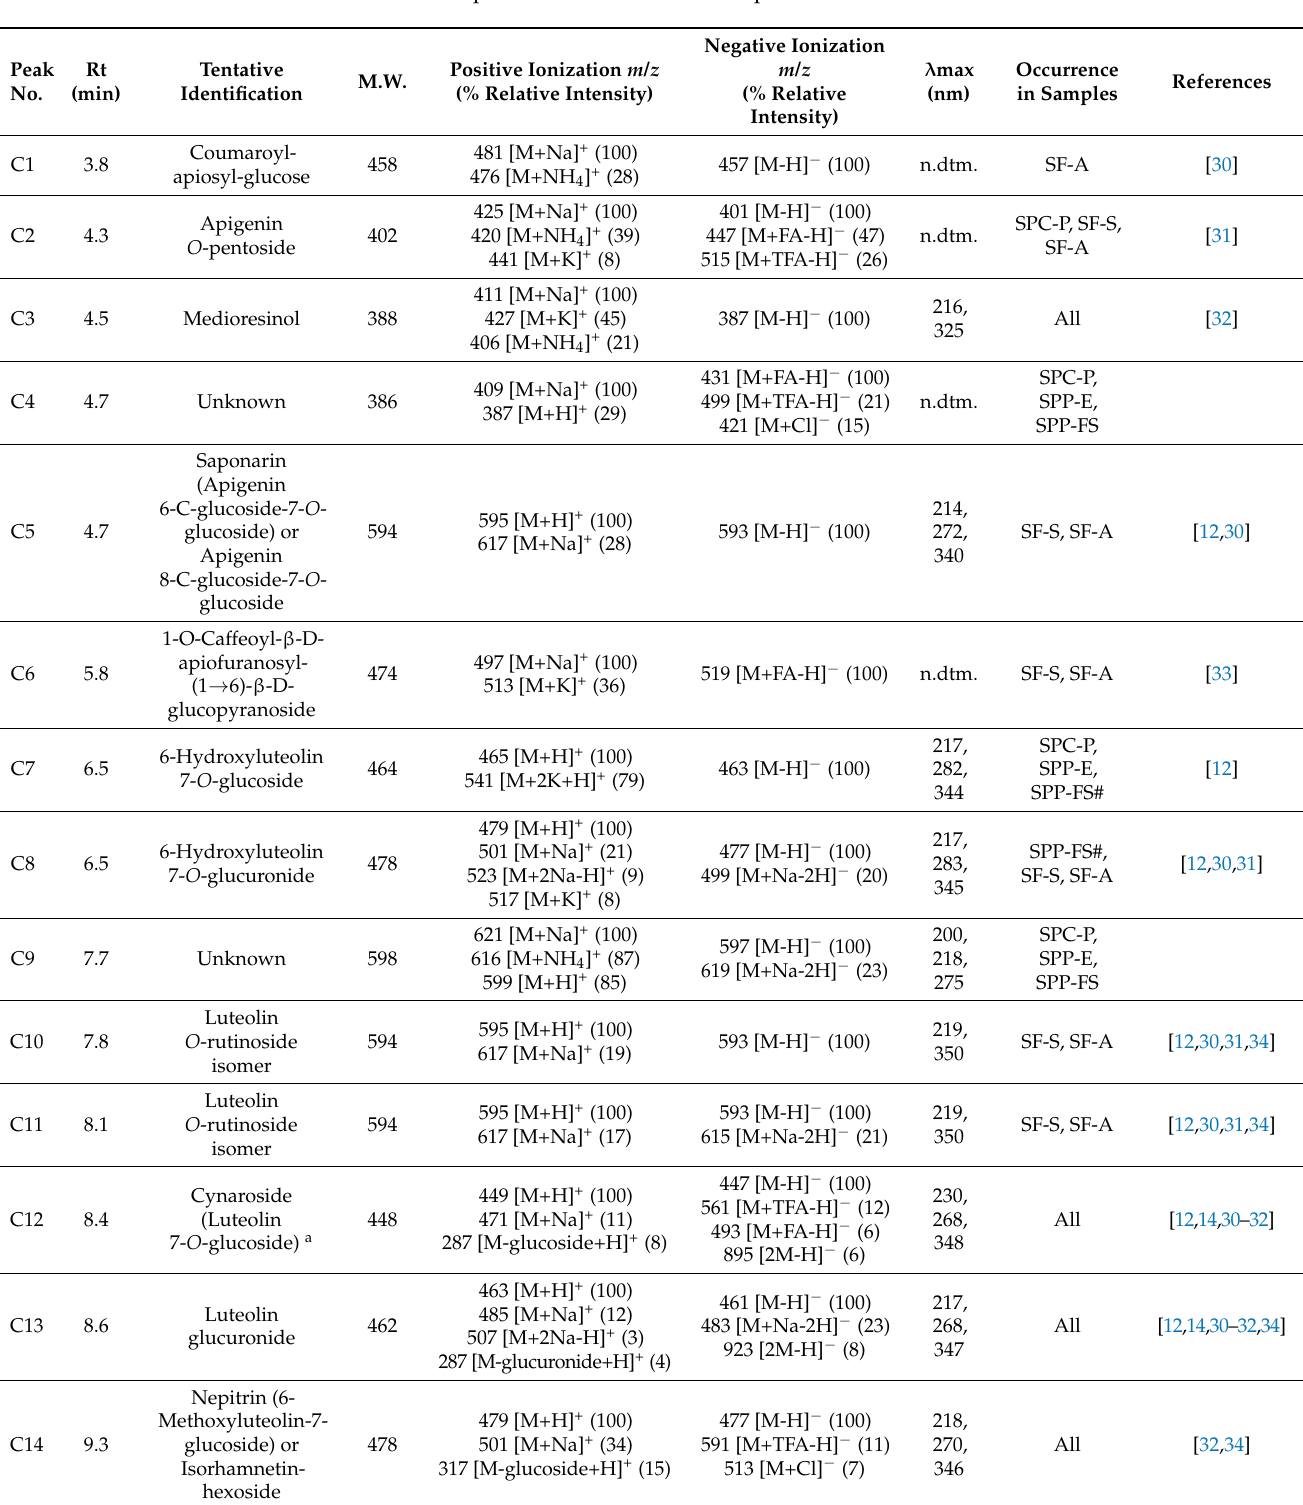
Table 2. Polar metabolites identified in hydroalcoholic extracts of the five Salvia samples using UHPLC–DAD–ESI–MS on a C18 column. The retention times, the molecular weight, the ions observed after positive or negative ionization with a description of the ion origin with their relative abundance in parentheses, and the UV–vis absorption maxima are presented herein. The Salvia sample in which each compound was determined is presented in the eighth column. The previous studies that helped the characterization are provided in the last